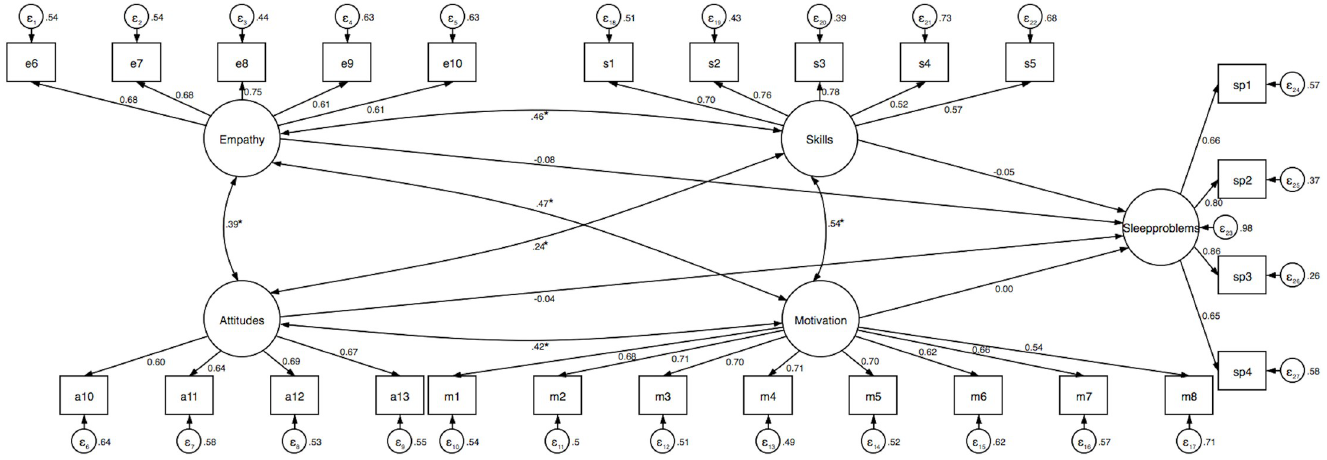
Fig 3. Structural equation model examining the association between cross-cultural competence and sleep problems. Standardized coefficients are reported and the significance levels of paths and covariates presented here are for the standardized regression coefficients. Model adjusted for gender, age, employment sector, and frequency of interacting with patients and colleagues from different cultures. Goodness-of-fit indices: χ 2 (289) = 1167.68, p < .001, RMSEA = 0.06, CFI = 0.89, SRMR = 0.05 (index obtained from the estimation of goodness-of-fit of the model tested with the maximum likelihood, n = 816). R 2 sleep problems = 1.8%. � p < .001.